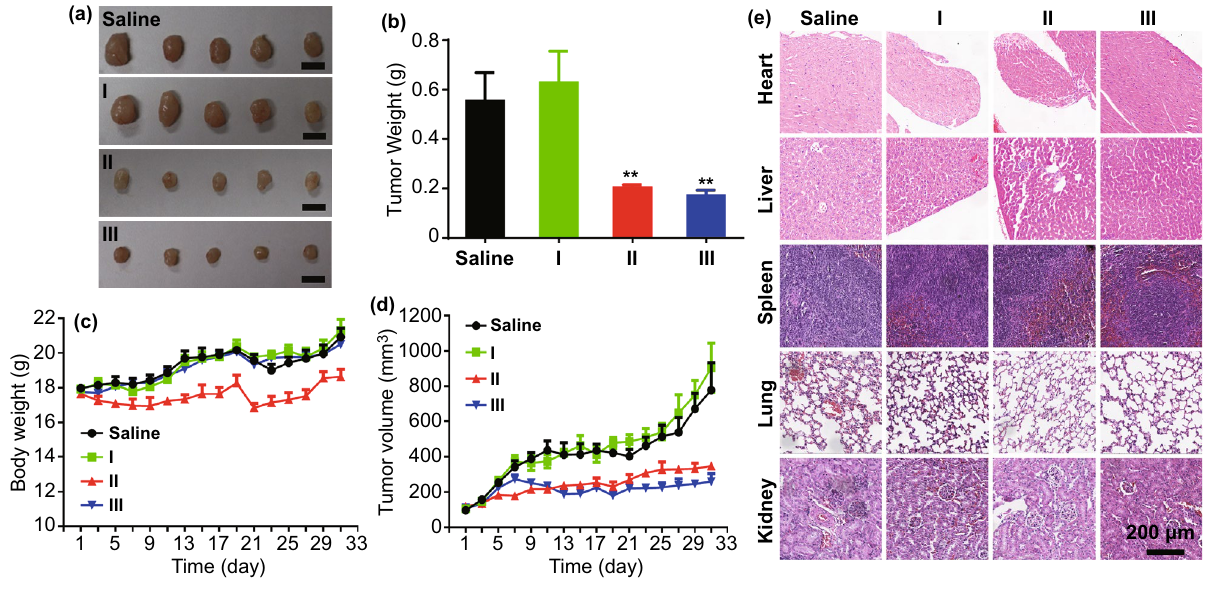
Fig. 5 Cancer chemotherapy in vivo using PAA 68 – b –PEG 86 – b –PAA 68 /MnO 2 (I), free DOX (II), and DOX-loaded PAA 68 – b –PEG 86 – b –PAA 68 / MnO 2 (III) in MCF-7 tumor-bearing mice. a Digital images of tumors from MCF-7 tumor-bearing mice after 31 days in vivo cancer chemo- therapy, scale bar: 1 cm. b Weight of tumor excised from MCF-7 tumor-bearing mice after treatment. c Body weight changes of MCF-7 tumor- bearing mice during therapy. d Tumor size change of MCF-7 tumor-bearing mice during therapy. e Histological analyses of major tissues from MCF-7 tumor-bearing mice after 31 days in vivo cancer chemotherapy, scale bar: 200